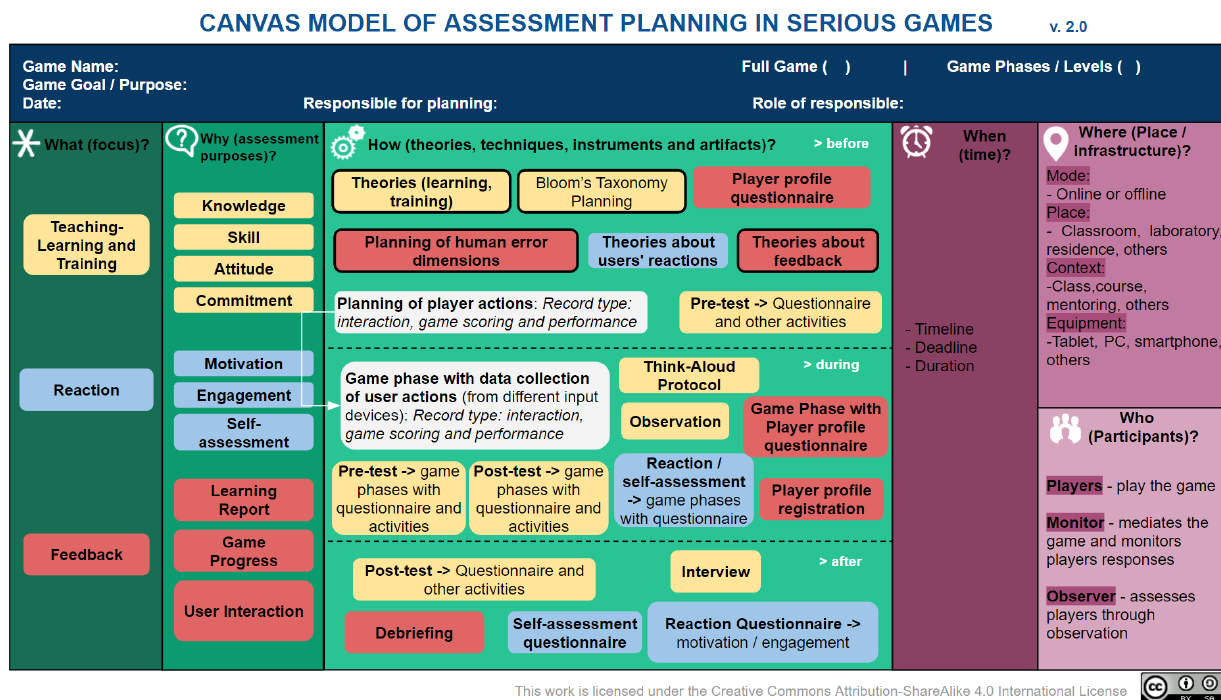
Figure 4. Canvas model for the planning of the assessment in SGs: examples of contents.